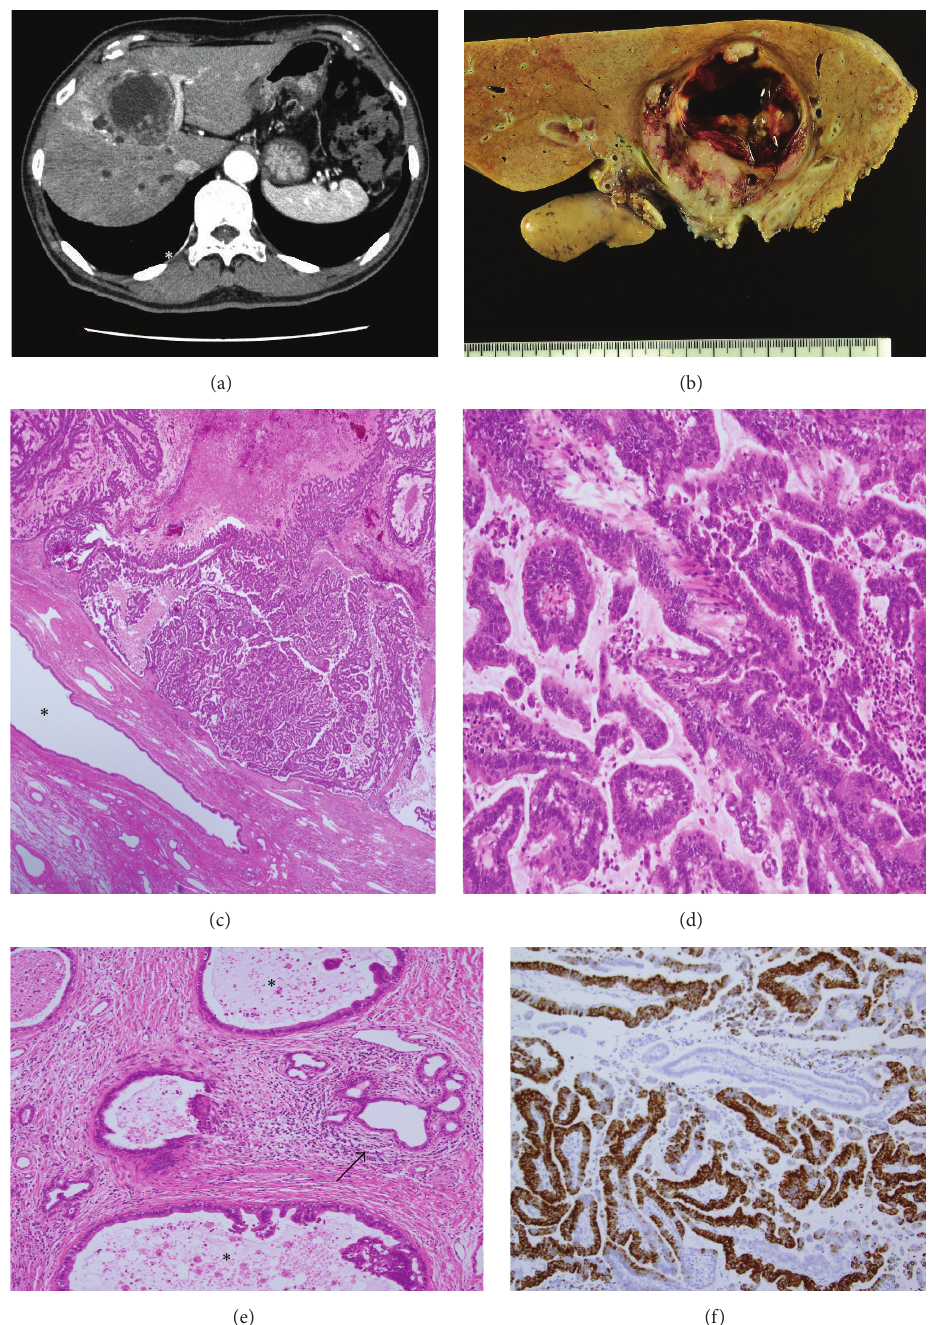
Figure 2: Case 2 . (a) Contrast-enhanced CT shows a cystic lesion (60mm in diameter) with an enhanced wall near the hepatic hilus. (b) A cystic tumor with fibrous wall is found in segment 4, adjacent to the hepatic hilus. (c) Histologically, well-differentiated papillary adenocarcinoma with thin fibrovascular cores fills the cystic space of the tumor. ∗ Surrounding nonneoplastic bile duct. Original magnification, 30x; H&E staining. (d) Papillary carcinoma with columnar epithelia and fine fibrovascular cores. Original magnification, 120x; H&E staining. (e) Invasion of carcinoma ( ∗ ) in the periductal tissue of adjacent bile ducts. The arrow denotes the nonneoplastic peribiliary glands. Original magnification, 100x; H&E staining. (f) Papillary carcinoma is positive for MUC6. Original magnification, 100x; immunostaining for